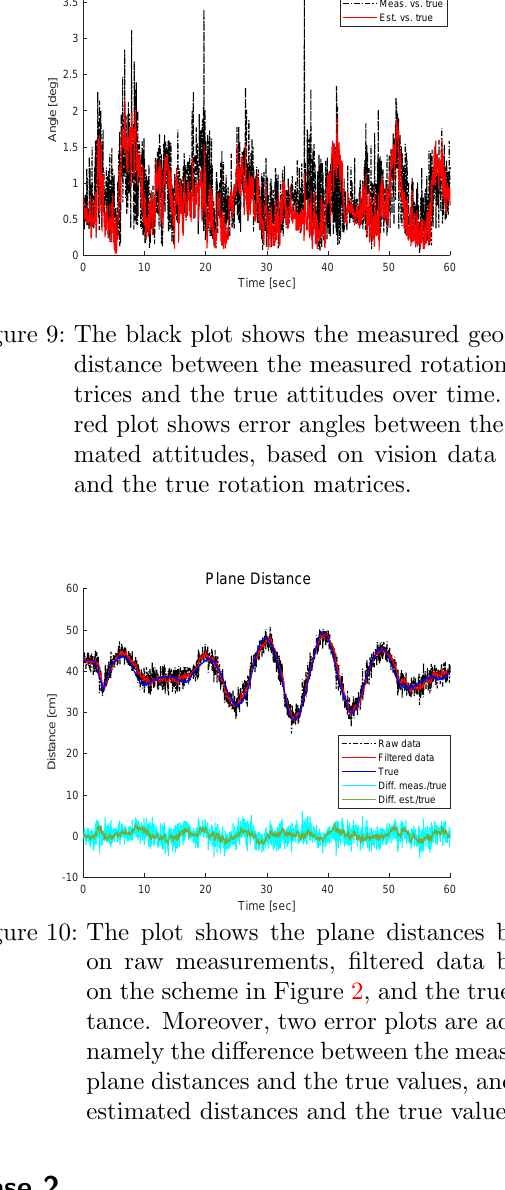
In Case 2 the time history and the measurements of Case 1 was used, and in addition, measurements were included from one gyroscope at the robot sensor pack- age and one gyroscope at the ship deck. The filter gains were K R = 6, K ω = 15, K b = 0 . 01, K 1 = 7